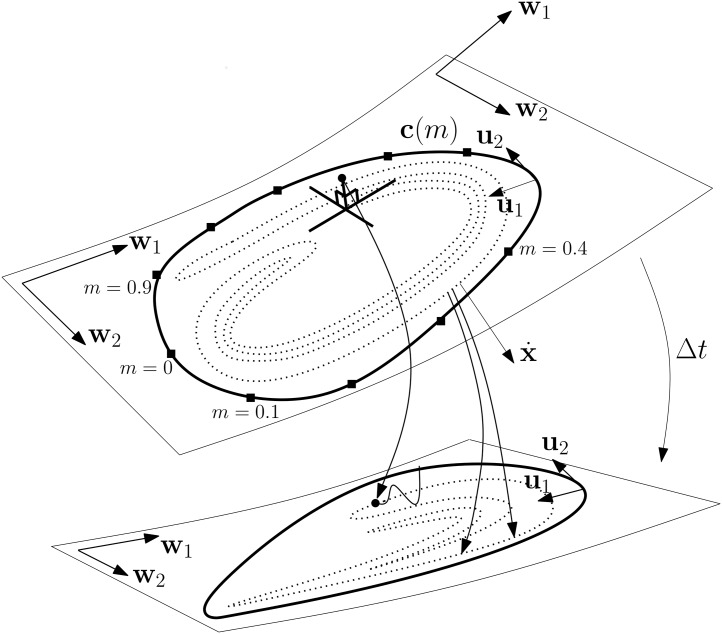
Schematic of AM and BM.An off-manifold point with stable orthogonal motion is shown. The unit vector u1 points in the inward direction and the unit vector u2 is tangential to the BM. The vectors w1(x) and w2(x) span the tangent space of the AM. On the BM (u1,u2) and (w1,w2) span the same 2-D tangent space. Here, the dimension of the AM, M, is 2.